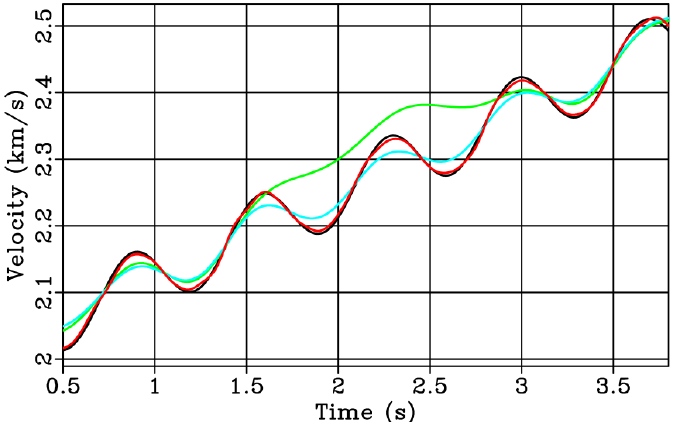
Figure 5. Picked velocity values from different semblances, where the black curve represents the true values of velocities, the green curve represents the picked velocities from the conventional semblance, the cyan curve represents the AB semblance, and the red curve represents our new method.